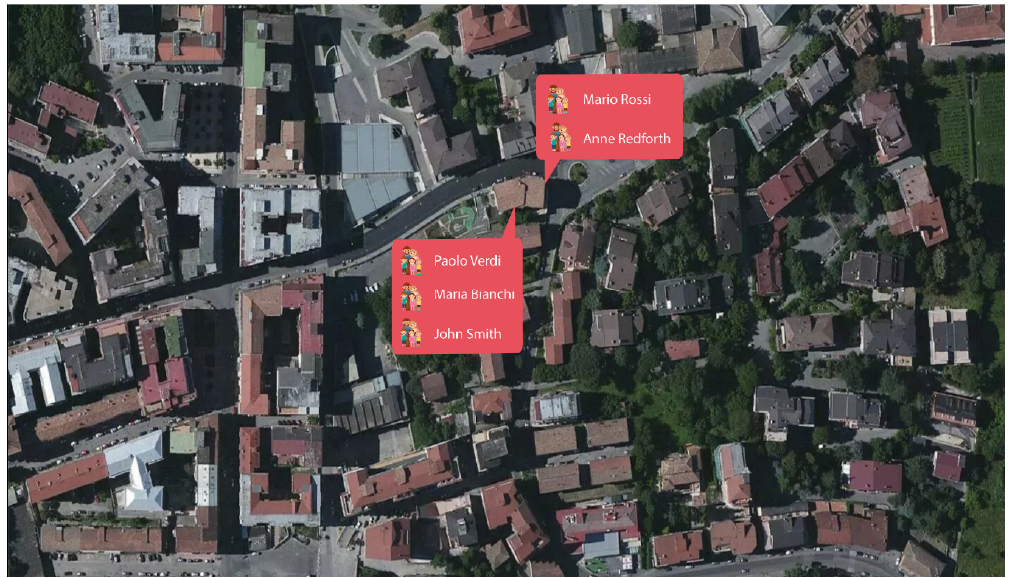
invoked again. In particular, a label for each Family is displayed containing data about the family